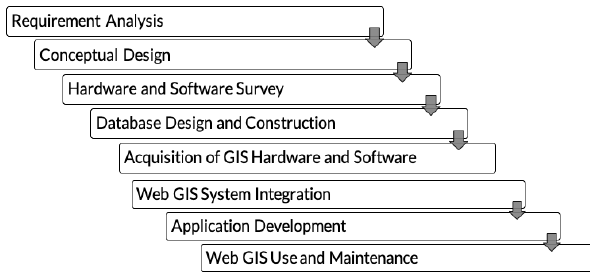
Figure 2. WebGIS development cycle (Alesheikh et al., 2019).